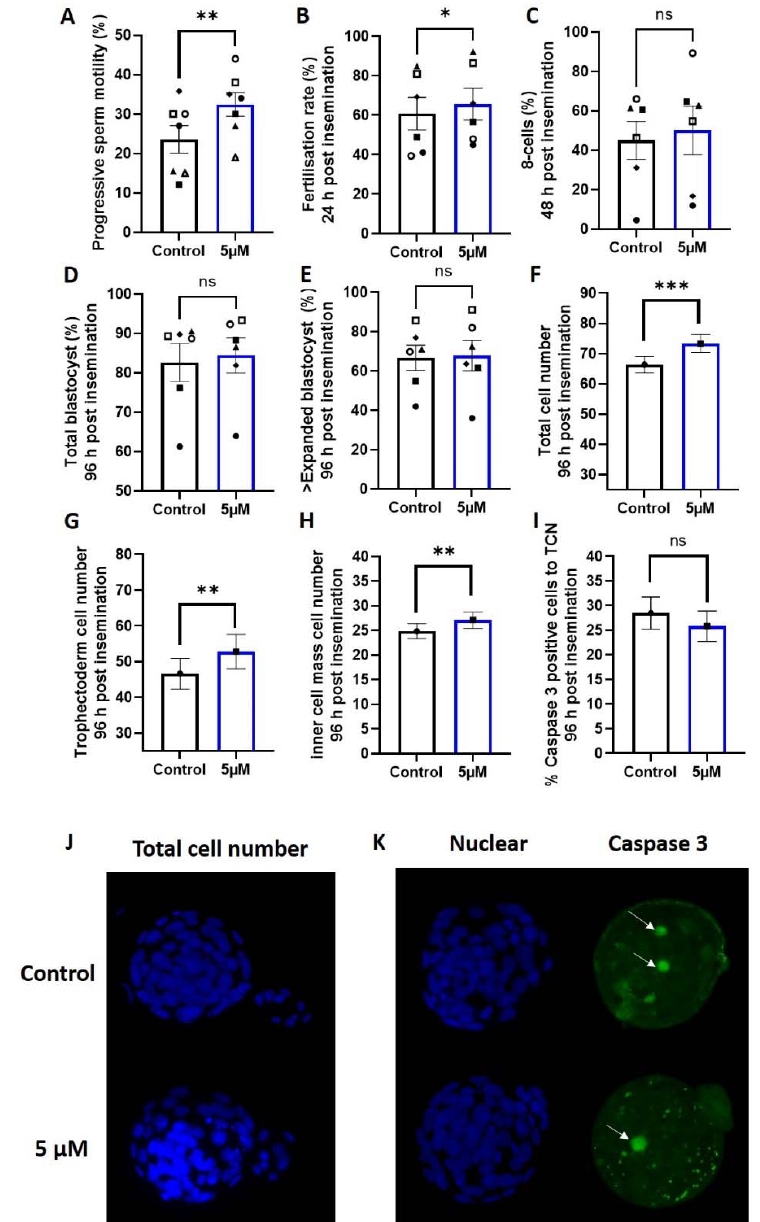
Figure 2. 5 µ M idebenone in vitro increases sperm motility, fertilization rates and total cell numbers in embryos generated from advanced paternal age. ( A ) Progressive sperm motility, ( B ) Fertilization rate from number of MII oocytes inseminated, ( C ) Percentage of 8 cell embryos 48 h post insemination from number that fertilized, ( D ) Total blastocyst ( ≥ early blastocyst) 96 h post insemination from number that fertilized, ( E ) Percentage of ≥ expanded blastocyst (on time) 96 h post insemination from number that fertilized, ( F ) Total cell number of blastocyst 96 h post insemination, ( G ) Trophectoderm cell number of blastocyst 96 h post insemination, ( H ) Inner cell mass cell number of blastocysts 96 h post insemination, ( I ) Percentage of caspase 3 positive cells in blastocysts 96 h post insemination, ( J ) Representative images of total cell number (blue) for control and 5 µ M idebenone generated blastocyst 96 h post insemination and ( K ) Representative images of Caspase 3 positive staining (green) for control and 5 µ M idebenone generated blastocysts 96 h post insemination. 804 control and 788 5 µ M idebenone embryos assessed for embryo morphology from 6 male biological replicates;